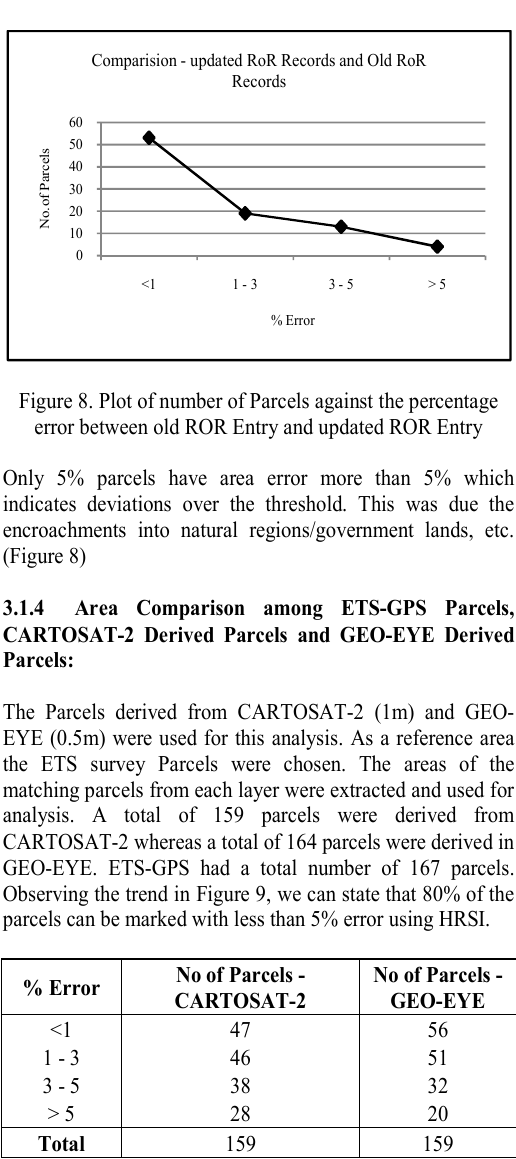
Table 5. Comparison of Area deviation with respect to ETS- GPS in CARTOSAT-2 and GEO-EYE